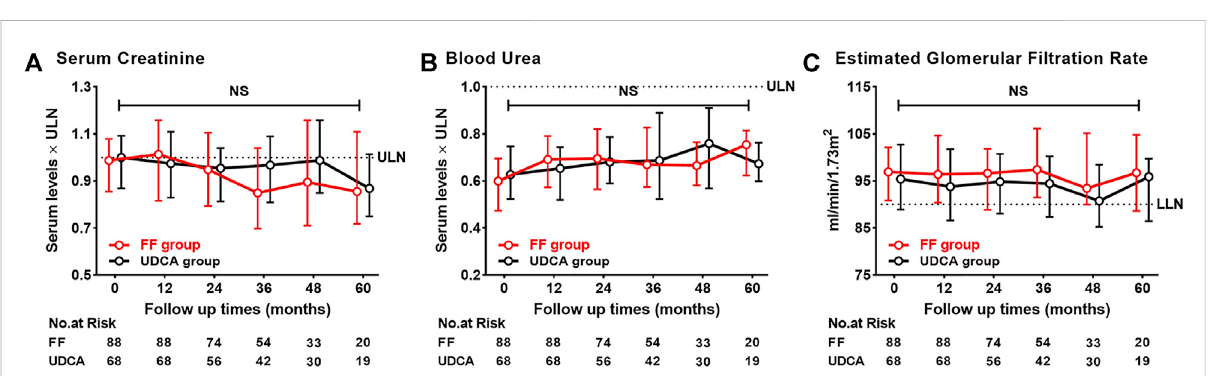
FIGURE 10 Dynamic changes of parameters with follow-up time (A) Serum Creatinine (B) Blood Urea (C) Estimated Glomerular Filtration Rate. Group,